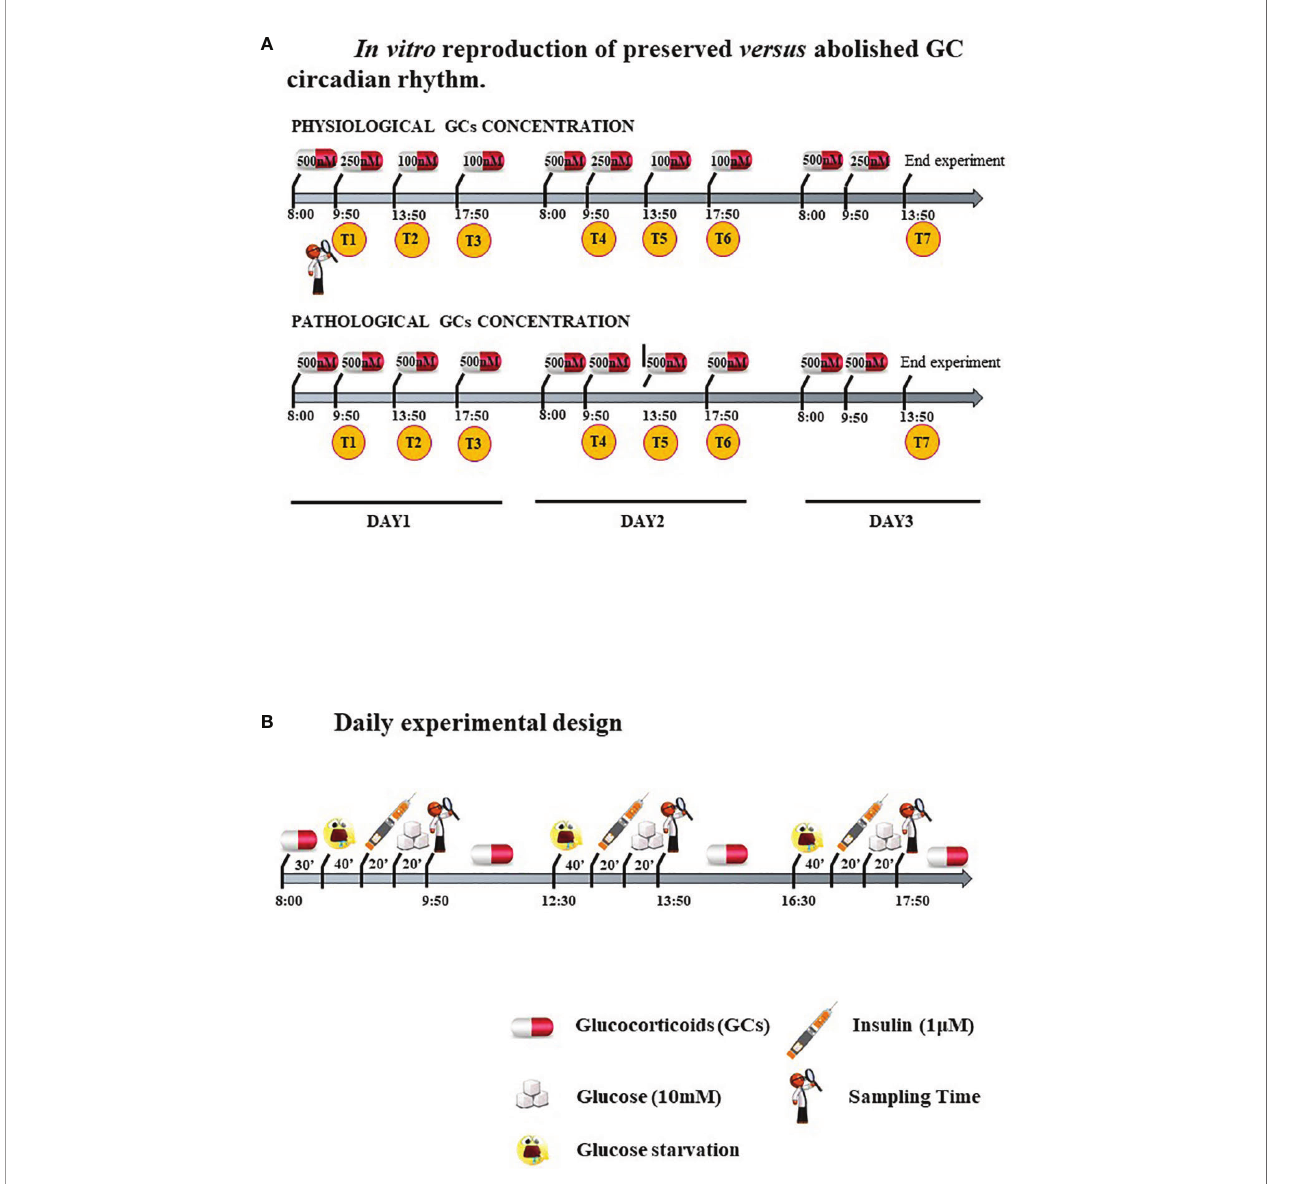
FIGURE 1 | (A) In vitro reproduction of preserved versus abolished GC circadian rhythm. (B). Daily experimental